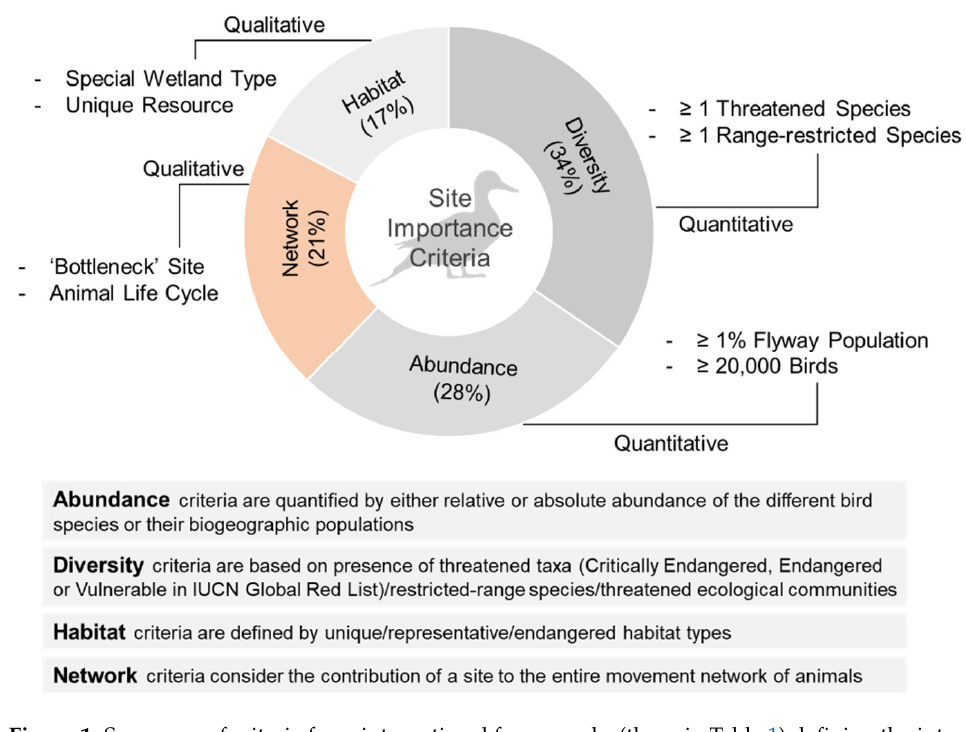
Figure 1. Summary of criteria from international frameworks (those in Table 1) defining the international importance of a site for bird conservation.